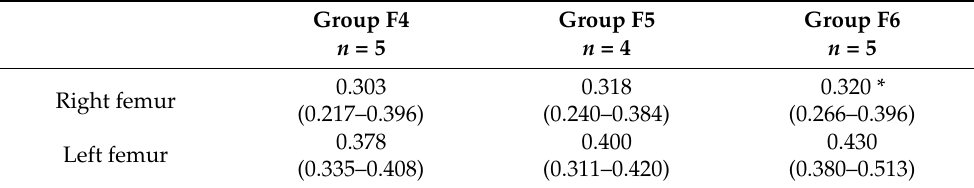
Table 3. Bone mineral density (g/cm 2 ) of rat femurs from experimental groups F4, F5 and F6 at post-operative day 90. Data are presented as medians